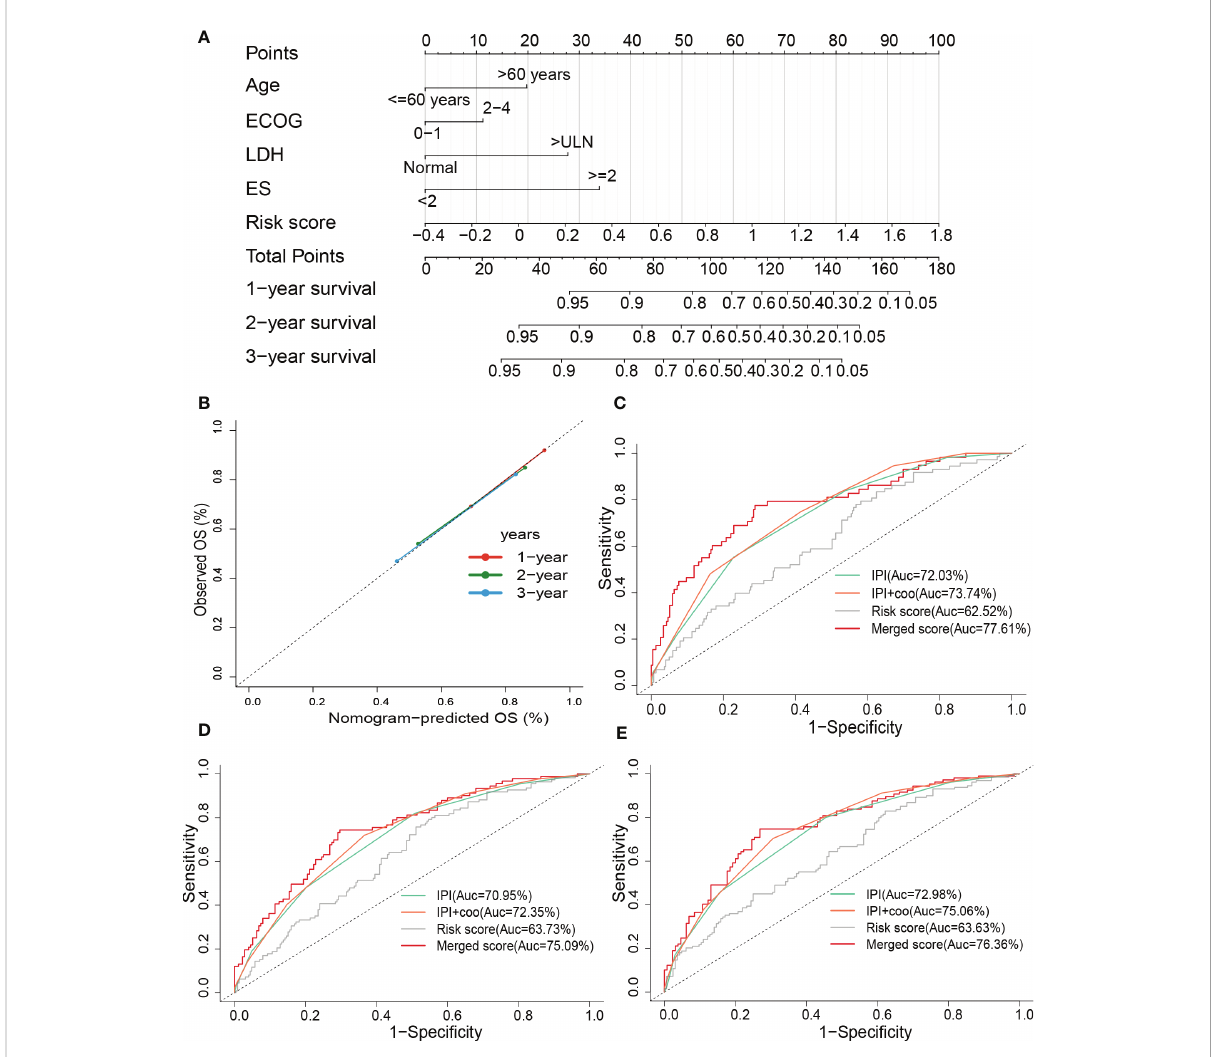
FIGURE 7 Constructing and evaluating the combined nomogram. (A) The nomograms with age, LDH, ES, ECOG, and risk score. (B) Calibration curves of the nomogram for predicting 1-, 2-, and 3-year survival. ROC curves of the nomogram, risk score, COO+IPI, and IPI score for (C) 1-year and (D) 2-year, and (E) 3-year survival prediction. LDH, lactate dehydrogenases; ES, extranodal sites; ECOG, The Eastern Cooperative Oncology Group performance score; ROC, receiver operating characteristic; COO, cell of origin; IPI, International Prognostic